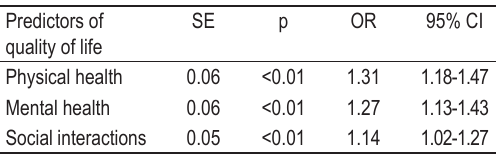
TABLE 5. Odds ratio for better work ability in the model of binary logistic regression with three areas of quality of life (binary variables) as predictors Predictors of quality of life